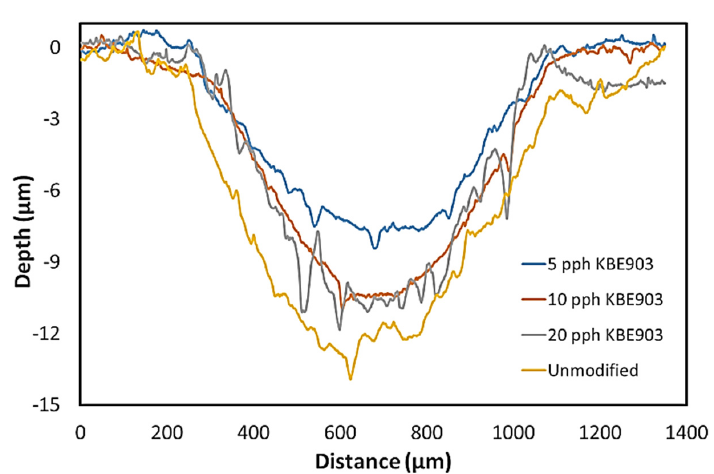
Figure 5. Worn surface profiles of non-treated (unmodified) and treated Sm 2 O 3 /UHMWPE compo-